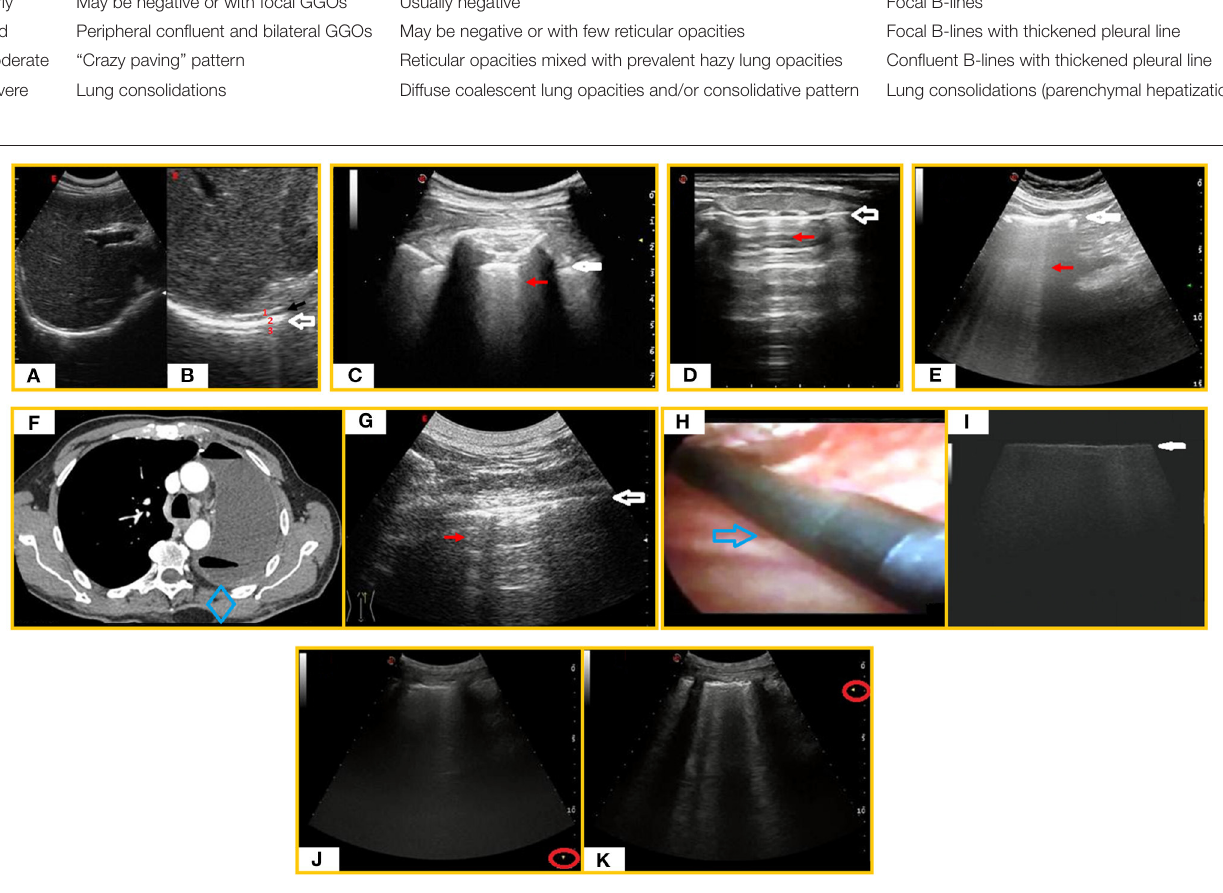
FIGURE 1 | LUS artifacts. (A) Subcostal right ultrasound (US) scan with a convex probe (6 MHz). (B) Magnification on the “diaphragmatic hyperechoic line” (white arrow) showing that it is actually composed of three hyperechoic lines (1. hepatic capsule/diaphragmatic muscle interface line, 2. diaphragmatic muscle/pulmonary base interface line, 3. mirror reflection artifact) within which the real diaphragmatic muscle appears as a thin hypoechoic line (black arrow). (C) LUS scan with a convex probe (6 MHz) in a healthy individual showing the “hyperechoic pleural line” (white arrow) followed by a sporadic B-line (red arrow). (D) Longitudinal tracheal US scan with a linear probe (8 MHz) showing a “tracheal hyperechoic line” at the soft tissue/tracheal air interface (white arrow) followed by reverberation artifacts (red arrow). (E) Abdominal US scan with a convex probe (6 MHz) showing a “hyperechoic peritoneal line” (white arrow) followed by laser-like vertical and confluent ring down artifacts (red arrow). (F) Axial chest CT scan in a post-pneumonectomy patient revealing air and fluid collection in the residual space with mediastinal sliding. The intact lung is shifted toward the residual cavity. (G) US scan of the post-pneumonectomy space [corresponding to the blue box in the (F) CT scan] revealing a hyperechoic interface line (white arrow) followed by reverberation artifacts (red arrow). (H) Image of the pulmonary parenchyma of a patient diagnosed with usual interstitial pneumonia UIP during VATS. A sterile intracavitary laparoscope probe (12 MHz) with 10-mm diameter and 38-cm length (blue arrow) was introduced through one of the VATS ports in the thoracic cavity. (I) Intraoperatory LUS scan (linear probe, 12 MHz) showing an irregular increased thickness of the pleura line (white arrow) with no artifact below it. (J,K) LUS scans showing how modification of focus position (red round) can modify the number of vertical